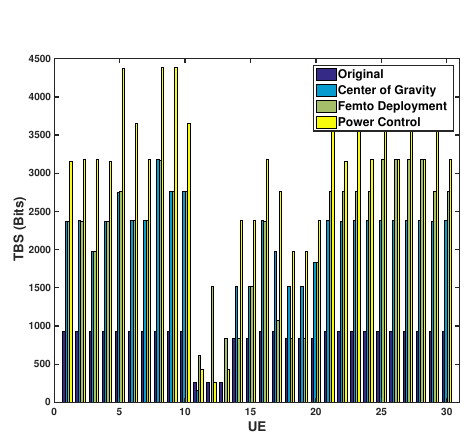
Fig. 16 indicates that the SINR values of the communication link between macro eNodeB and the three edge UEs are less than 5 dB in the Original scenario, which implies the poor quality of physical links. Nonetheless, in the Power scenario, the SINR values are increased from zero in the Centroid scenario back to and even above those in the Original